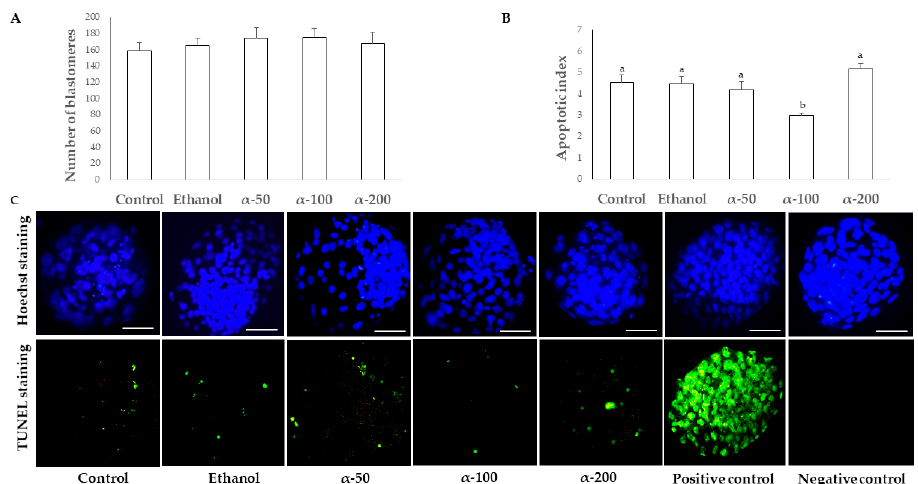
Figure 3. Effect of different α -tocopherol concentrations during bovine oocyte in vitro maturation on ( A ) total cell number, and ( B ) blastocyst apoptotic index. ( C ) Representative digital images of Hoechst and TUNEL staining of day 9 blastocysts derived from bovine oocytes collected during summer and in vitro matured in absence (control and 0.05% ethanol) or presence of α -tocopherol at 50 ( α -50), 100 ( α -100), 200 ( α -200) μ M, and positive and negative TUNEL assay controls. The white bar represents the 50 μ m mark. Different letters above each bar represent significant differences ( p < 0.05).